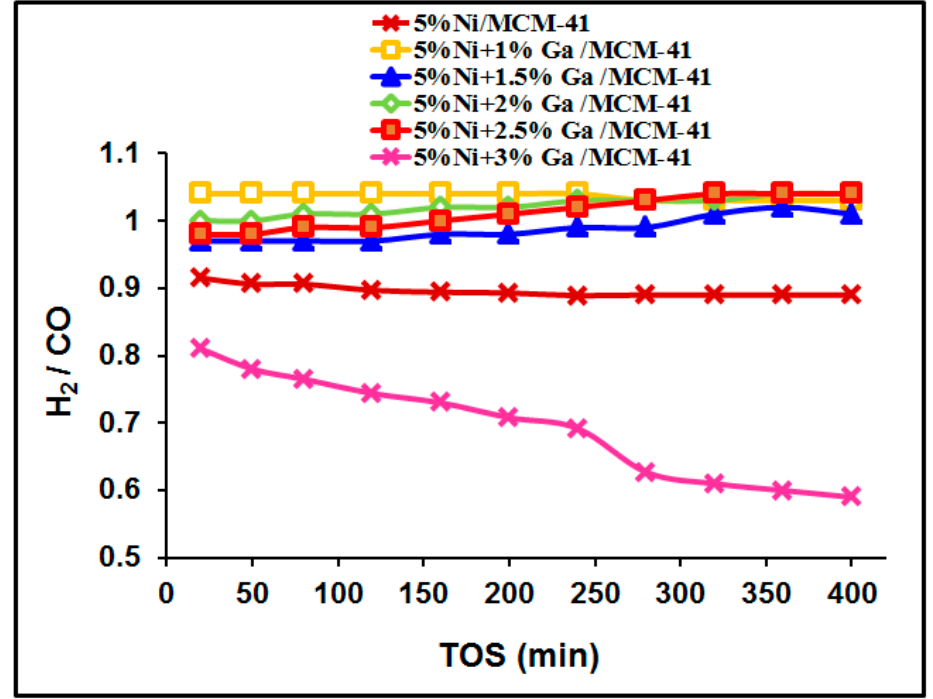
Figure 9. Graph of H 2 /CO ratio with time over different nickel-based catalysts at 800 °C reaction temperature, at atmospheric pressure, CH 4 :CO 2 = 1:1 in the feed gas, catalyst weight: 0.1 mg, WHSV: 2100 mL g − 1 h − 1 .